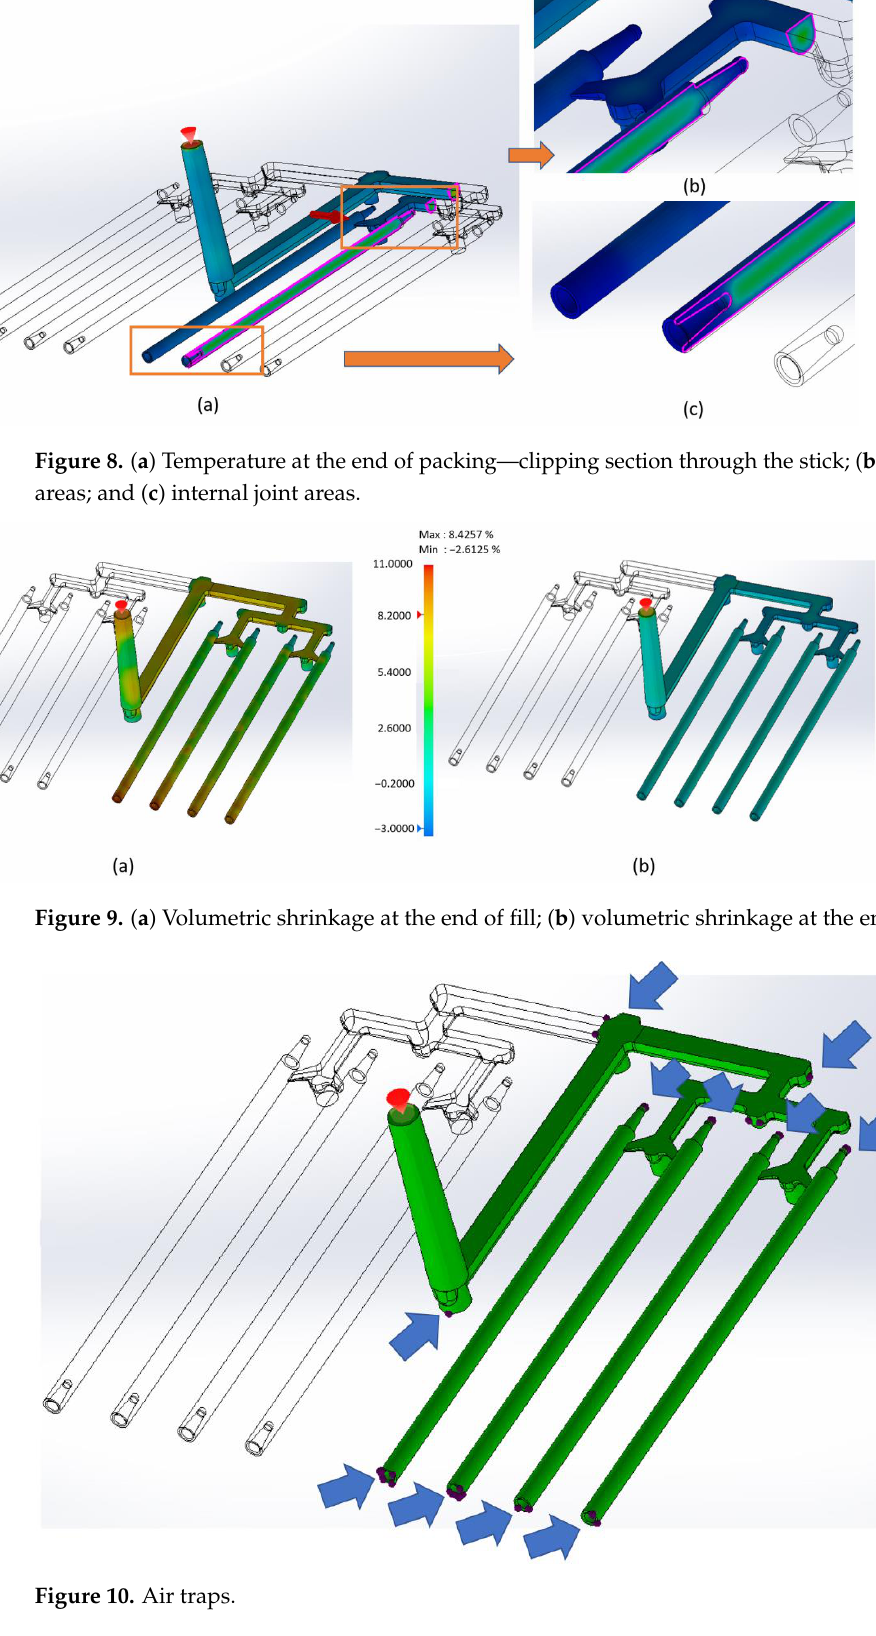
Figure 11. PCL stick produced using parameters developed during the simulation: ( a ) stick at the end of the injection molding process; ( b ) produced part; and ( c ) PCL filament sticks. 4. Discussion Achieving high-quality parts is a crucial task for the injection molding of sticks for further 3D printing of implants. With computer simulation, potential defects, such as air trap, weld line positions, and sink mark, emerging during the injection molding process can be predicted, thus mistakes in the design can be modified without excessive expenses of time and money [4]. With thermoplastics injection molding simulation, the material data are generally available from the simulation tools. Users could easily choose thermo- plastics material data to simulate entire phases of the thermoplastics injection molding process [26]. However, polycaprolactone data are not available in the data banks of com- mon injection molding simulation programs. Therefore, in this study, we created poly- caprolactone data from the literature. The basic material properties are listed in Table 1.